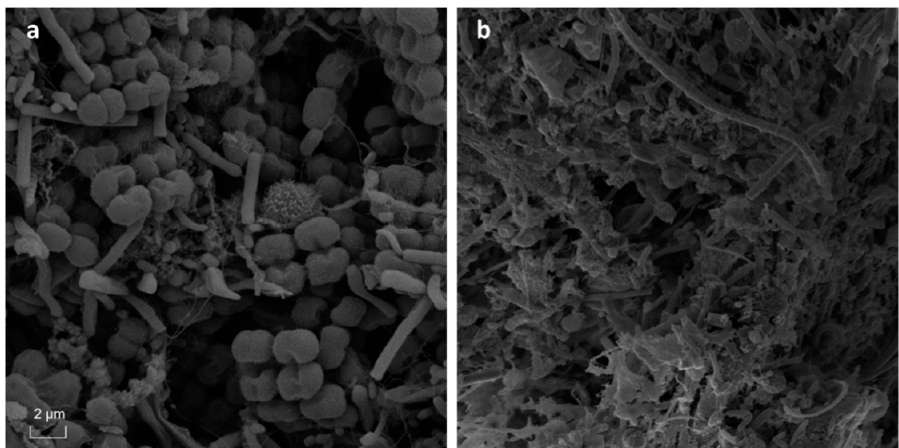
Figure 4. Temporal comparison of biofilm matrices formed on the test baffle strips using scanning electron microscopy (SEM) collected after ( a ) two and ( b ) seven months. After two months the biofilm shows greater microbial diversity, whereas the biofilm at seven months is rich in extracellular polymer substances (EPS).